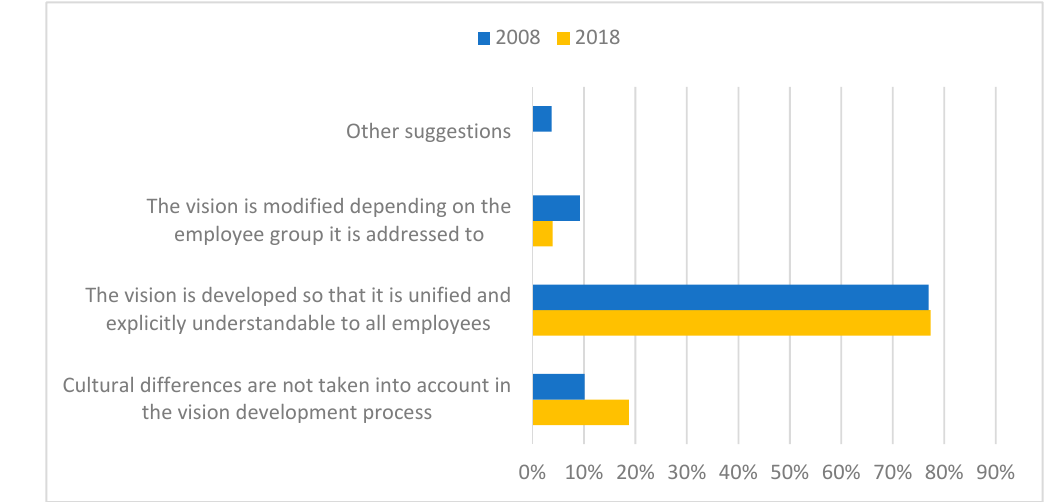
Figure 2. Impact of cultural differences on the communication of leader’s vision—Forbes Global 2000 corporation leaders’ assessment.